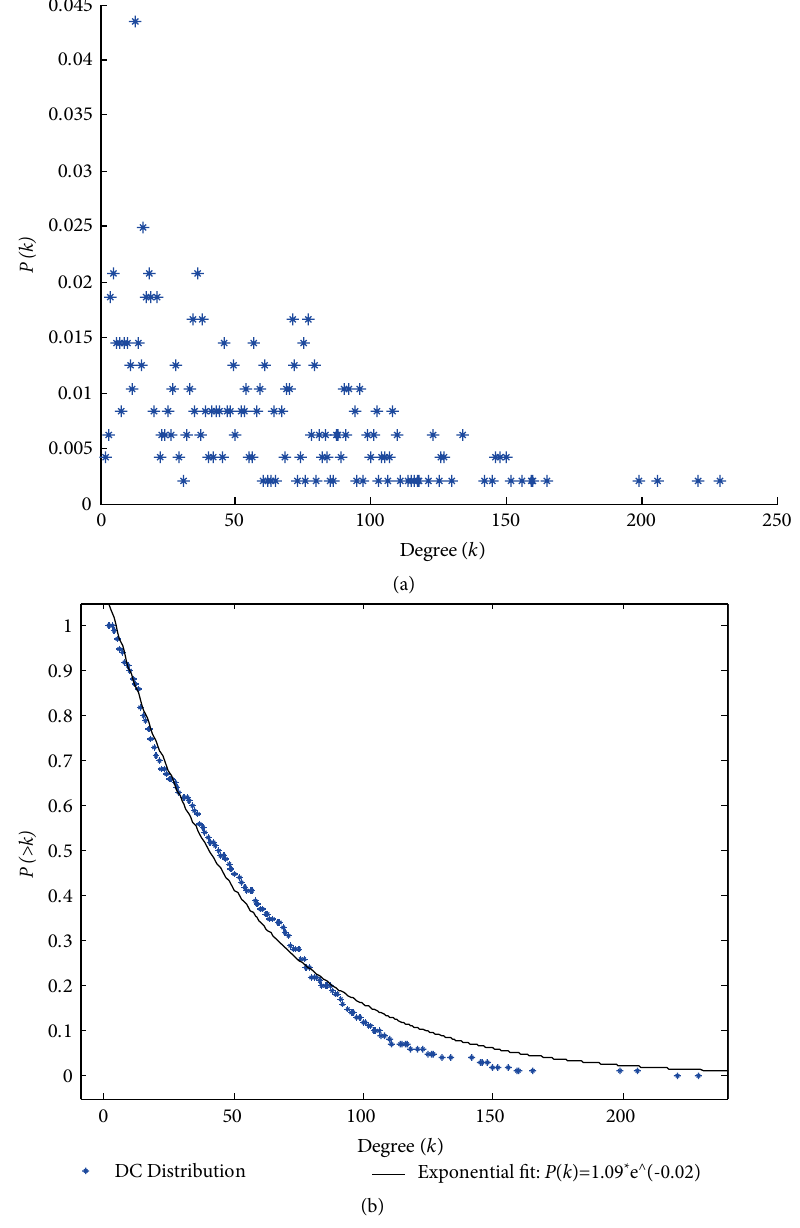
Figure 6: (a) Distribution and (b) exponential distribution of